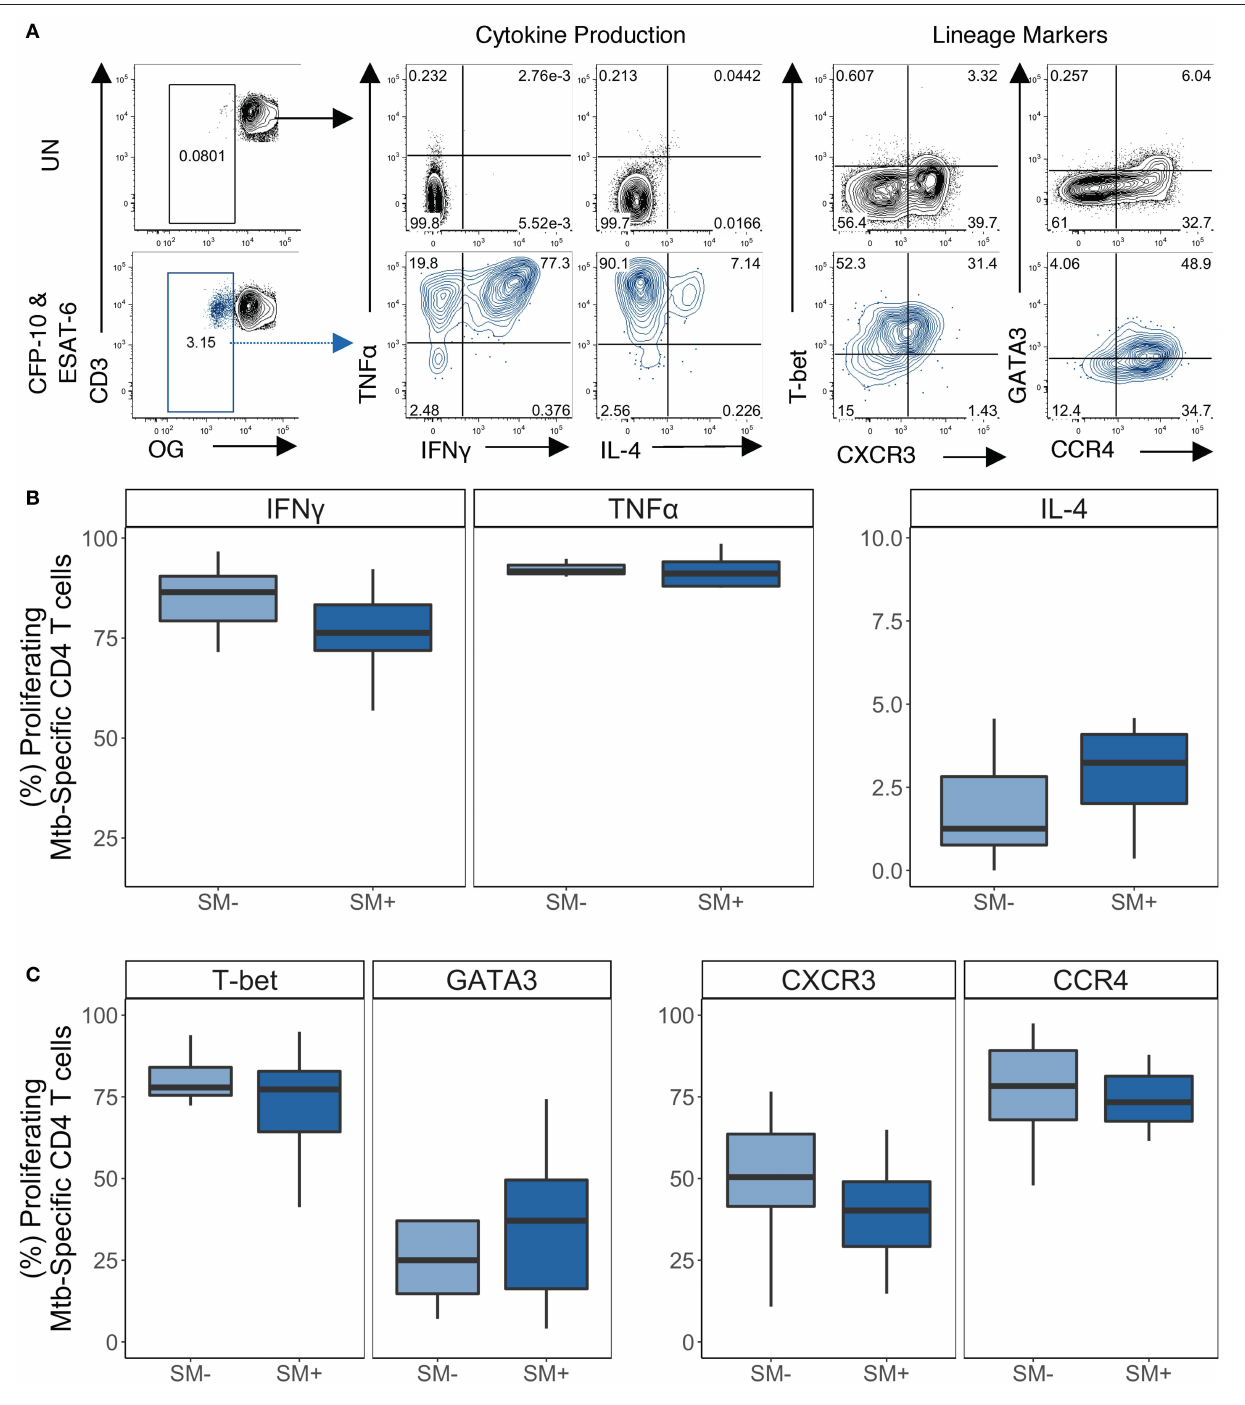
FIGURE 7 | Proliferating Mtb-specific CD4T cells have equivalent expression of TH1 and TH2 cytokines and lineage markers in SM + and SM − LTBI individuals. PBMCs from the CFP-10 and ESAT-6 stimulated condition were restimulated on day 5 with PMA and ionomycin for 5h to induce cytokine production. Samples meeting the criteria for a positive proliferative response (see Materials and Methods) were evaluated for cytokine production and expression of lineage specific transcription factors and chemokine receptors by flow cytometry (SM − , n = 10; SM + , n = 11). (A) Representative flow plots from an SM + LTBI individual. Unstimulated samples (upper) show cytokine production and phenotypes on cells gated on live CD3 + CD4 + CD8 − lymphocytes. CFP-10/ESAT-6-stimulated samples (lower) show cytokine production and phenotypes on cells gated on live OG lo CD3 + CD4 + CD8 − lymphocytes. (B) Frequency of TH1 cytokine + and TH2 cytokine + cells amongst proliferating CD4T cells. (C) Frequency of transcription factor + and chemokine receptor + cells amongst proliferating CD4T cells. Boxes represent the median and interquartile ranges; whiskers represent the 1.5*IQR. Differences in the frequency of each CD4T cell population between SM + and SM − individuals were assessed using a Mann Whitney U